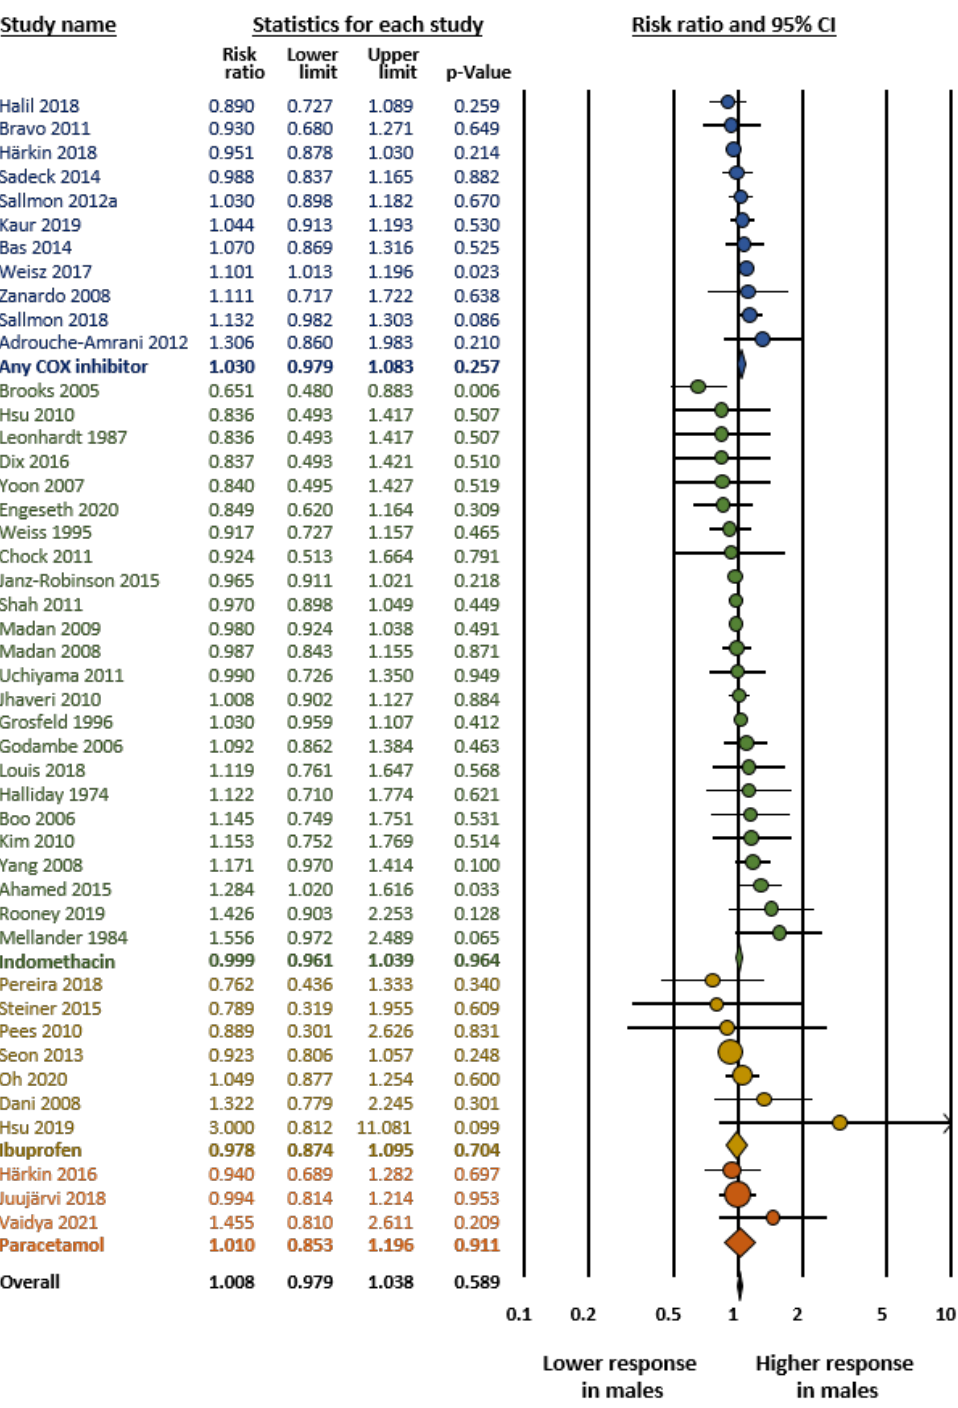
Figure 4. Meta-analysis on the association between sex of preterm newborns and rate of response to pharmacological treatment of patent ductus arteriosus (PDA). CI: confidence interval. COX: cy- clooxygenase. Risk ratio above 1 means higher response in males.